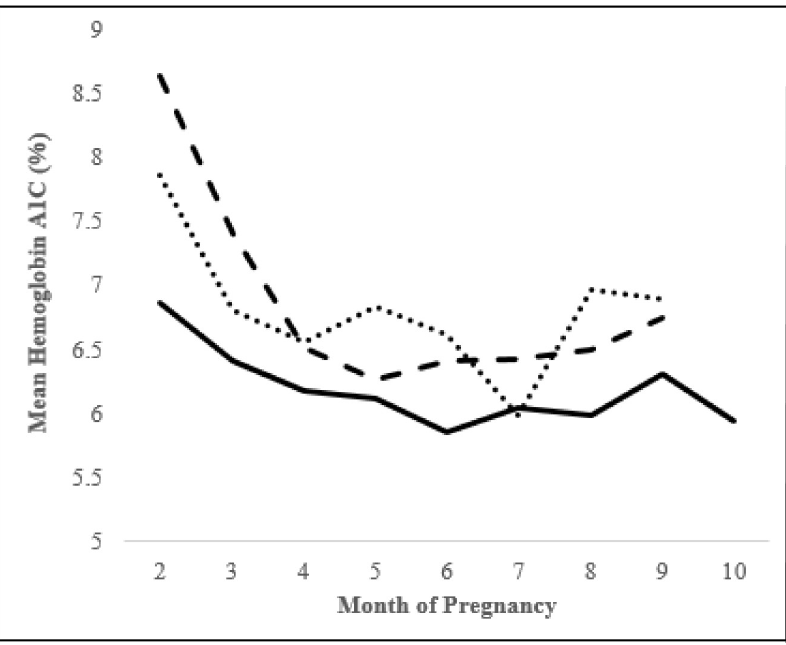
Fig 2. HbA1c throughout gestation. After adjusting for preconception HbA1c, there was a significant difference in changes in HbA1c over time between groups (p = 0.0042). Bold line represents CGM Share group, dashed line represents CGM Alone group, and dotted line represents no CGM group.